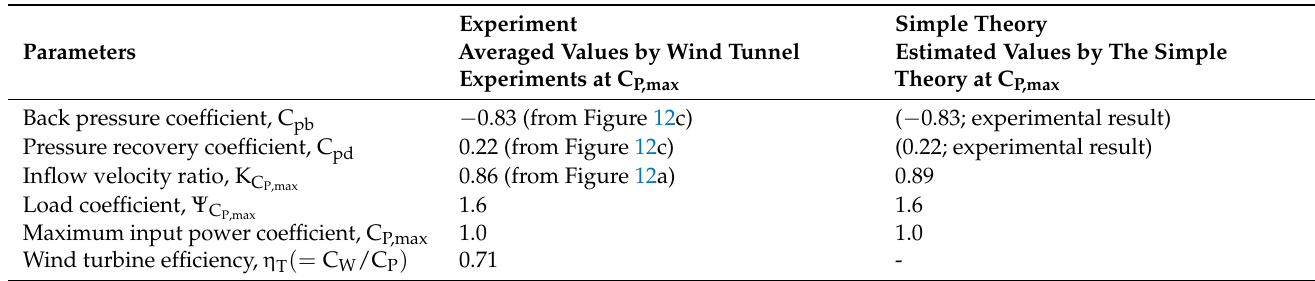
Table 3. Comparison of various coefficients between experiments and predictions by the simple theory at C P,max (at λ = 4.0) for a wind turbine with the compact Sii brimmed diffuser shown in Figure 9b.